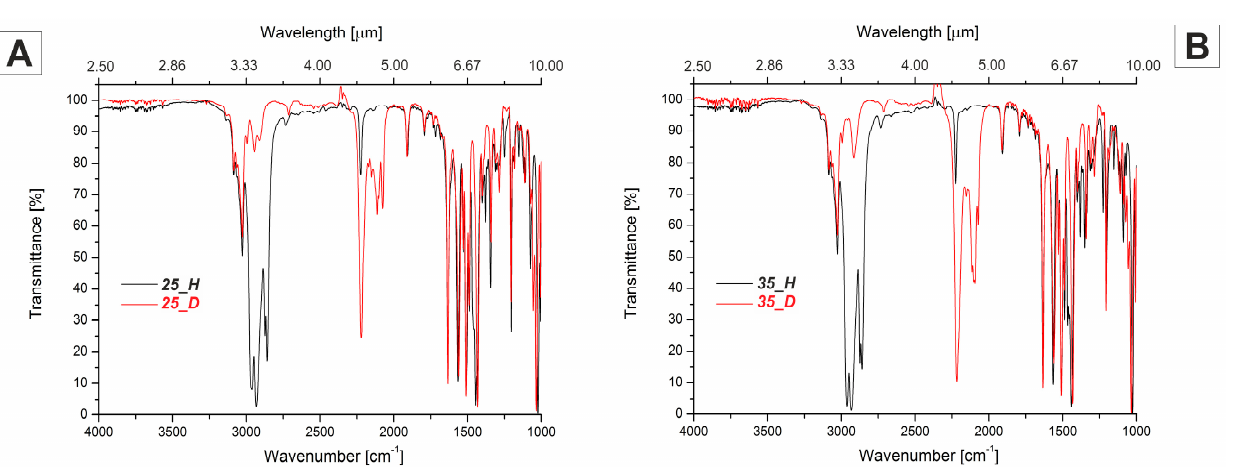
Figure 5. FT-IR spectra of selected isotopologues: ( A ) 25_H and 25_D, and ( B ) 35_H and 35_D.